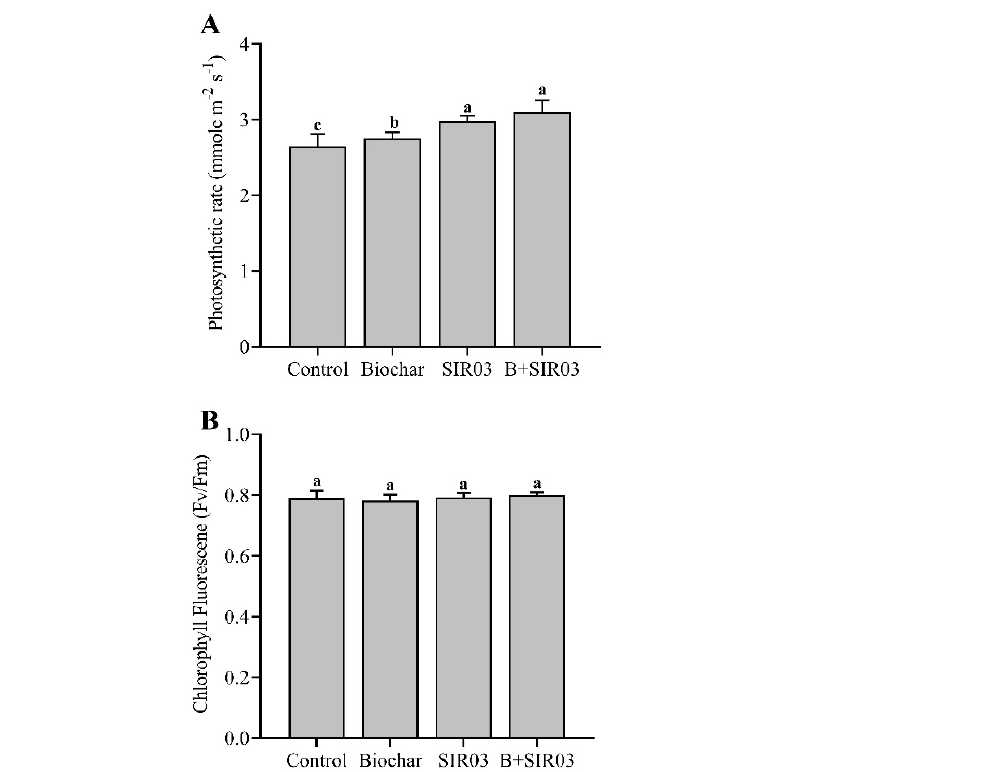
Figure 5. Effects of isolate SIR03 on ( A ) photosynthetic rate and ( B ) chlorophyll fluorescence in sesame seedlings. Control represents the (non-inoculated); Biochar represents biochar treated; SIR03 is the bacterial isolate; B+SIR03 represents the combined application of biochar and SIR03 strain. The values are means ± standard deviations of three replicates. Values indexed with different letters represent significant differences between treatments, evaluated by Duncan’s multiple range test at p < 0.05.